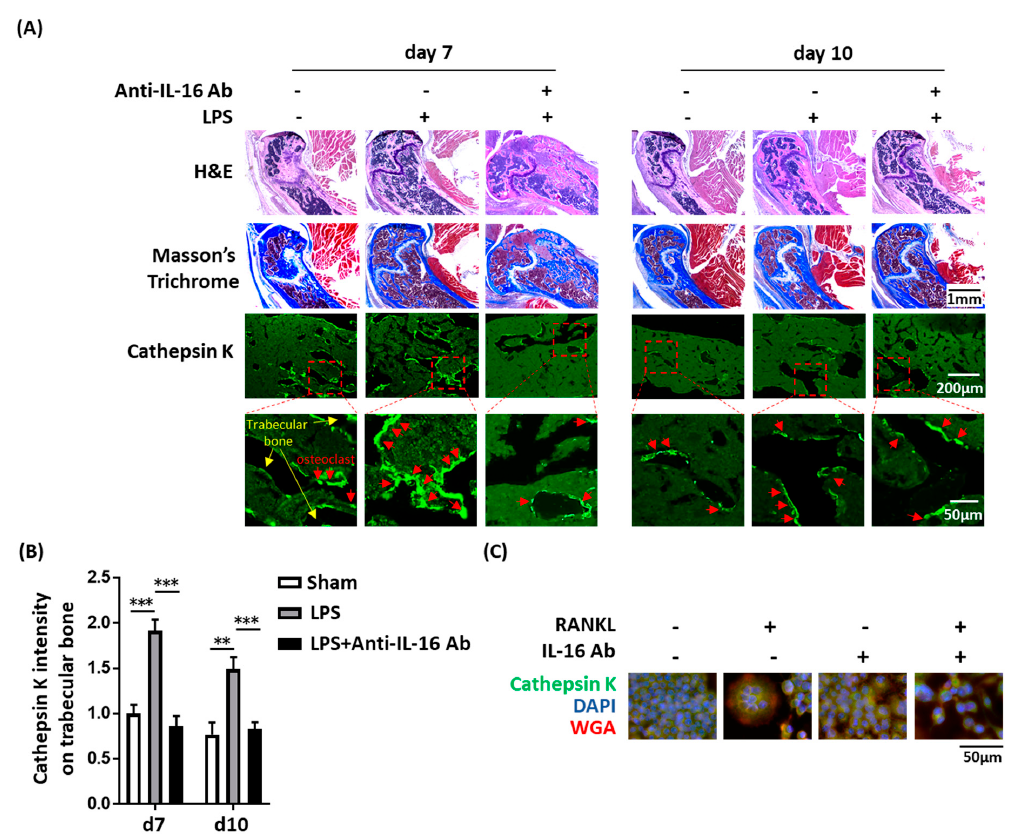
Figure 4. The anti-IL-16 antibody prevented LPS-induced loose trabeculae and cathepsin K expression in vivo and in vitro. ( A ) Mice received an intrafemoral injection of LPS or phosphate-bu ff ered saline (vehicle), histological sections presented loose trabeculae in the femoral bones of LPS-treated mice, intraperitoneal injections of the anti-IL-16 antibody were performed once daily for 4 consecutive days after LPS treatment, the anti-IL-16 antibody prevented LPS-induced loose trabeculae and cathepsin K expression in vivo; ( B ) Anti-IL-16 reduced LPS-enhanced cathepsin K intensity in the femoral trabecular bone in vivo; ( C ) The IL-16 antibody inhibited RANKL-mediated RAW264.7 cell di ff erentiation into cathepsin-K-positive osteoclast-like cells. Data are presented as means ± standard errors of the mean. Analyses were conducted using a two-way analysis of variance followed by Bonferroni’s post hoc test. * * p < 0.01, * ** p < 0.001. Abbreviations: IL, interleukin; LPS,